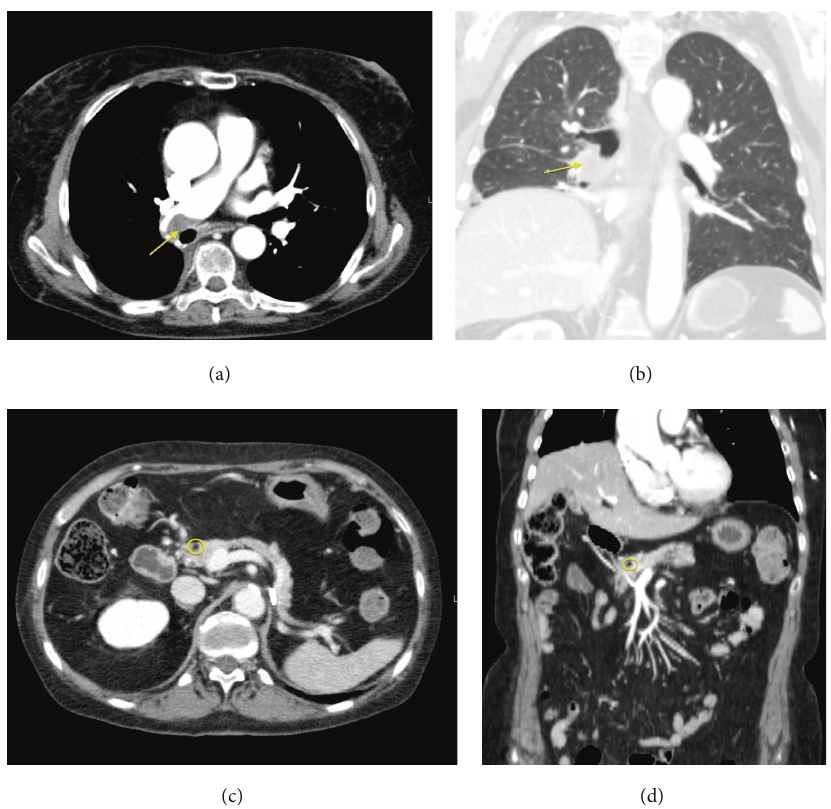
Figure 4: Images show the presence of the nodular lesion in the posterior basal segment of the inferior right lobe ((a) and (b)) and the pancreatic lesion after the treatment appeared hypodense due to necrotic-colliquative phenomena ((c) and (d)). (a) Axial CECT-Arterial Phase. (b) MPR-Coronal Plane-Lung Window. (c) CECT-Axial Plane. (d) CECT-MPR-Coronal Plane.